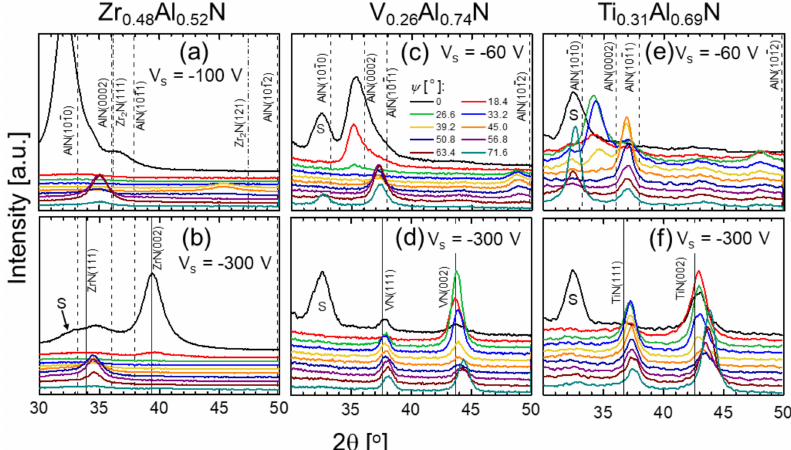
Figure 1. X-ray diffraction (XRD) θ –2 θ scans recorded as a function of the tilt angle ψ for: ( a ) Zr 0.48 Al 0.52 N ( V s = − 100 V); ( b ) Zr 0.48 Al 0.52 N ( V s = –300 V); ( c ) V 0.26 Al 0.74 N ( V s = –60 V); ( d ) V 0.26 Al 0.74 N ( V s = –300 V); ( e ) Ti 0.31 Al 0.69 N ( V s = –60 V); and ( f ) Ti 0.31 Al 0.69 N ( V s = –300 V) films. “S” denotes the forbidden 002 reflection from the Si substrate, which appears due to multiple